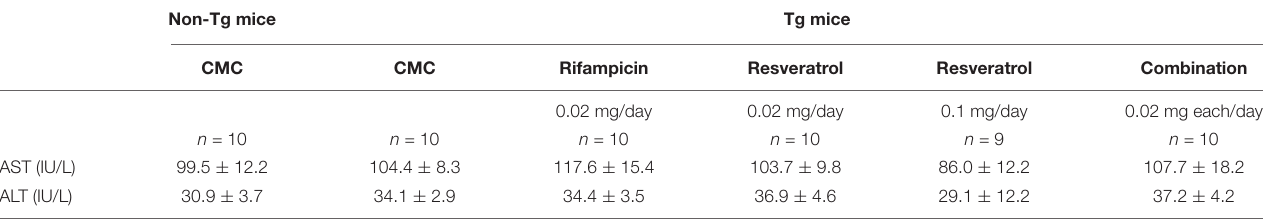
TABLE 1 | Plasma levels of liver enzymes in APP OSK mice after 1-month intranasal administration of rifampicin, resveratrol, and their combination. Non-Tg mice Tg